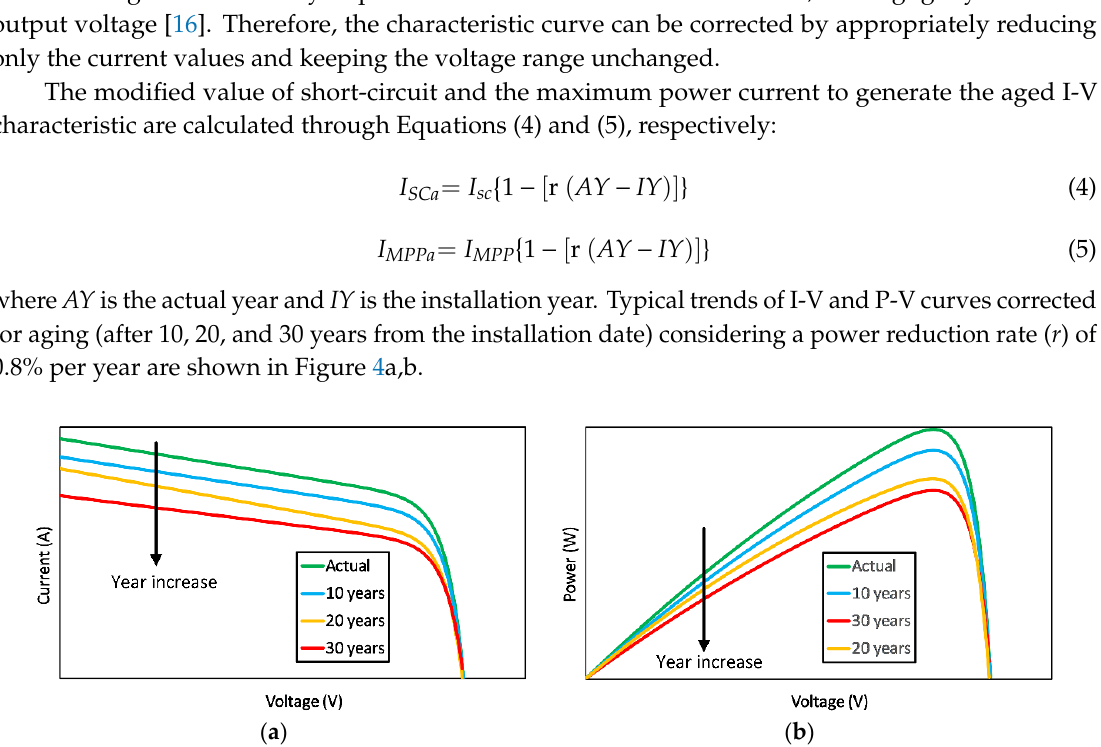
Figure4. Correctionof the characteristic curve based on aging (10, 20, and 30years). ( a ) I-Vcharacteristic; ( b ) P-V